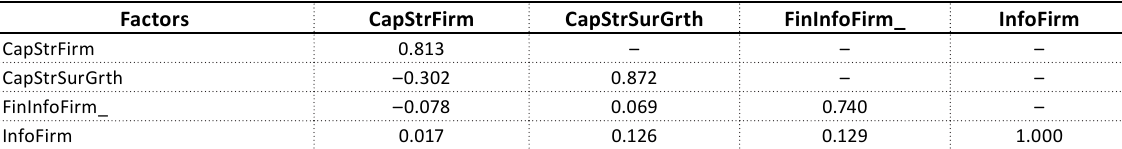
Table 2. Discriminant validity: Fornell-Larcker criterion